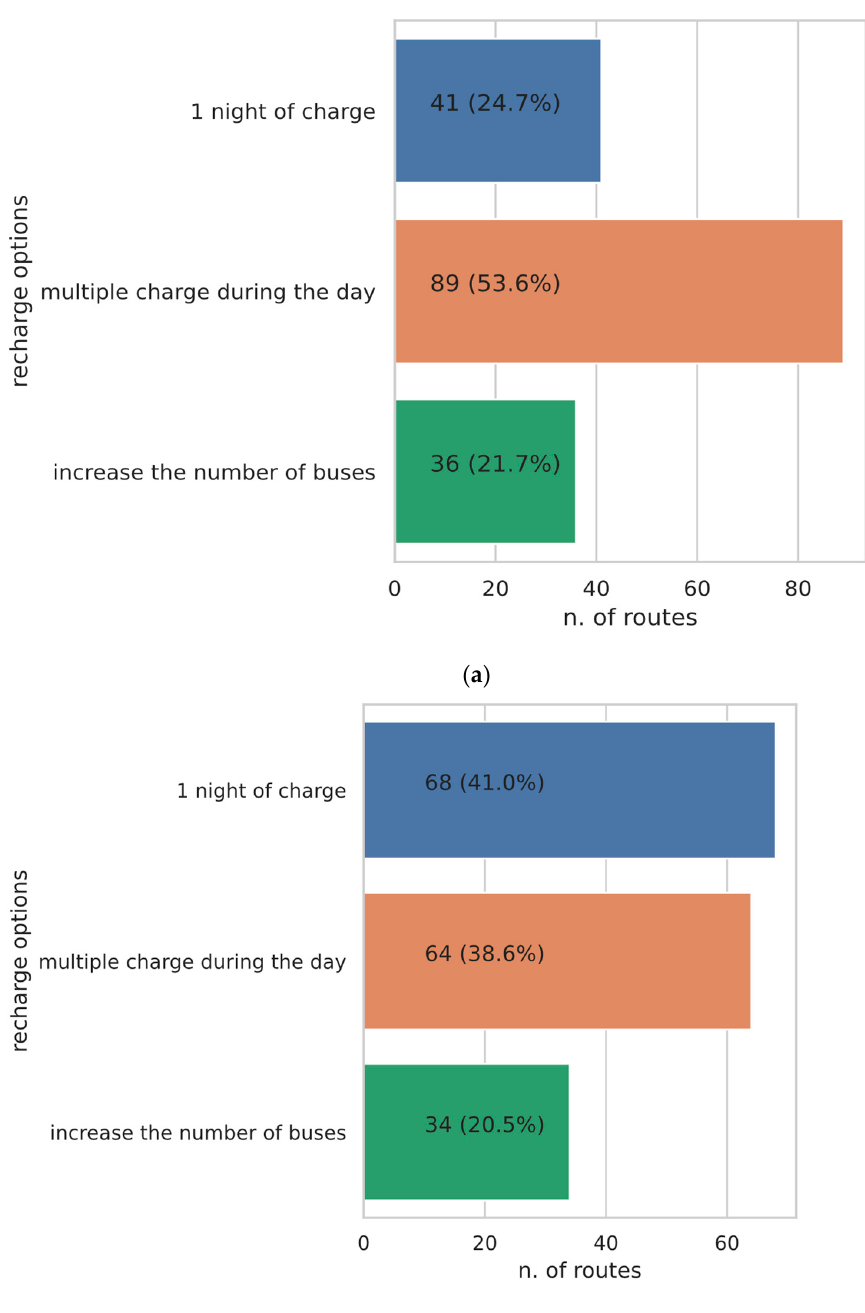
Figure 6. An example of the state of charge of a bus during the day travelling a specific line is shown. Each color represents a bus, the different line styles represent the bus status: the continuous line is the bus that is going to its destination (H), the dotted line is the bus that is on its way back to the origin (R), and dashed line is the bus that is waiting and/or recharging (recharge).